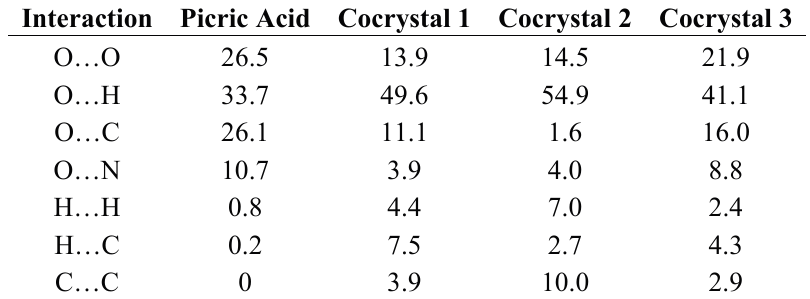
Table 2. Various contact contributions to Hirshfeld surface area in four crystals.